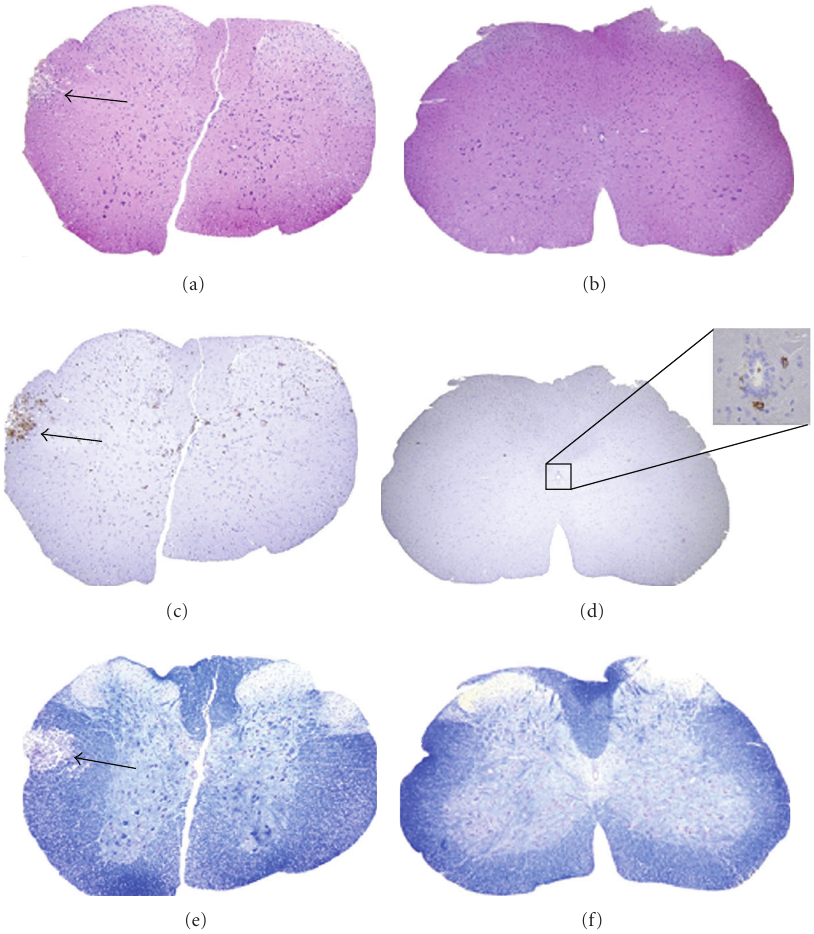
Figure 6: Comparative histopathology of MHV-A59- and MHV-2-infected mouse spinal cords. Serial cross-sections (5 μ m thick) from MHV-A59- and MHV-2-infected mouse spinal cord at day 5 post inoculation were stained with H & E (a, b), LCA (c, d), or LFB (e, f). Several inflammatory lesions (a) with infiltrating LCA+ cells (c) were observed in MHV-A59-infected mouse spinal cord (arrows indicate lesion area) whereas in MHV-2-infected mouse spinal cord no parenchymal lesions were observed (b), with only rare LCA+ infiltrates observed near the central canal (d). An adjacent section of MHV-A59-infected spinal cord shows loss of myelin by LFB staining ((e) arrow indicates demyelinated area) whereas normal myelin was observed in MHV-2-infected mouse spinal cord (f). Original magnification of (a–f) is 40x. (adapted from the work of